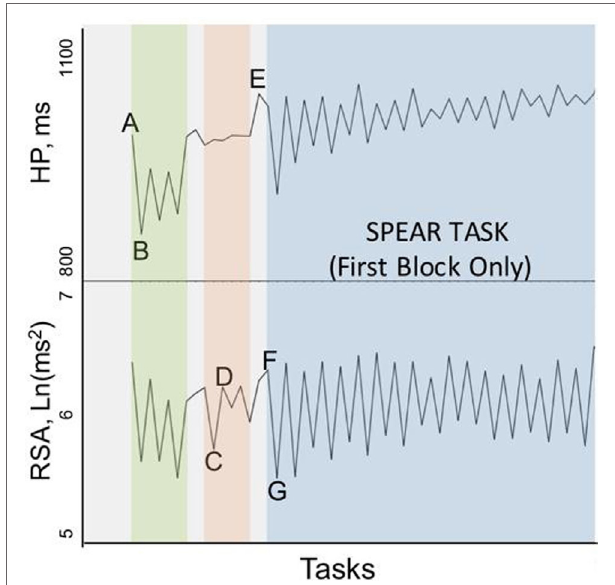
FigUre 7 | Mean heart period (HP) and respiratory sinus arrhythmia (RSA) cardiac reactivity pattern across the protocol. The mean HP (top) and mean RSA (bottom) over each period in the protocol (A–G) is illustrated. This figure highlights the pronounced cardiac reactivity pattern during the two phases of each trial of the Soldier Performance and Effective, Adaptable Response (SPEAR) task. The first 18 trials of the time ordered SPEAR task are shown to the right of F. The characteristic saw tooth pattern is the heart period (HP) and RSA signal change in response to meeting the demands of the “problem” and “response” phases of the SPEAR task. The regularity persisted in the second time ordered block for RSA but not HP. The tasks notations in the illustration are as follows: A = the initial seated baseline; B = Stand #1; C = Eriksen-Flanker; D = Post Eriksen-Flanker recovery; E = Final recovery baseline (FRB); F = SPEAR Trial 1 (A)—Information Receiving; G = SPEAR Trial 1 (B)—Solution